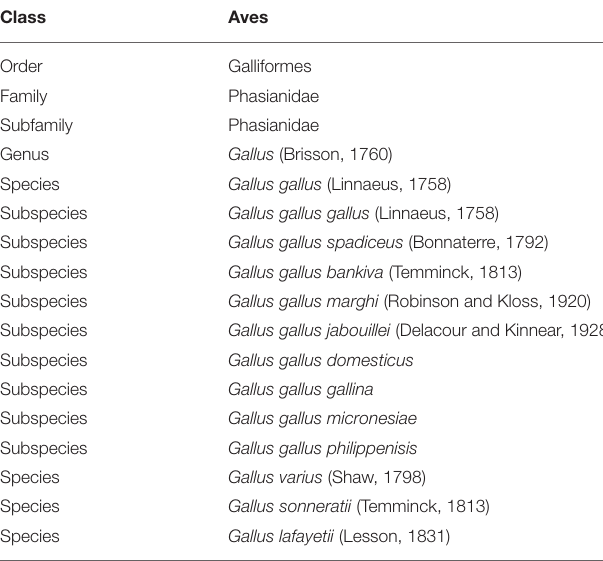
TABLE 1 | Taxonomy of the chicken.